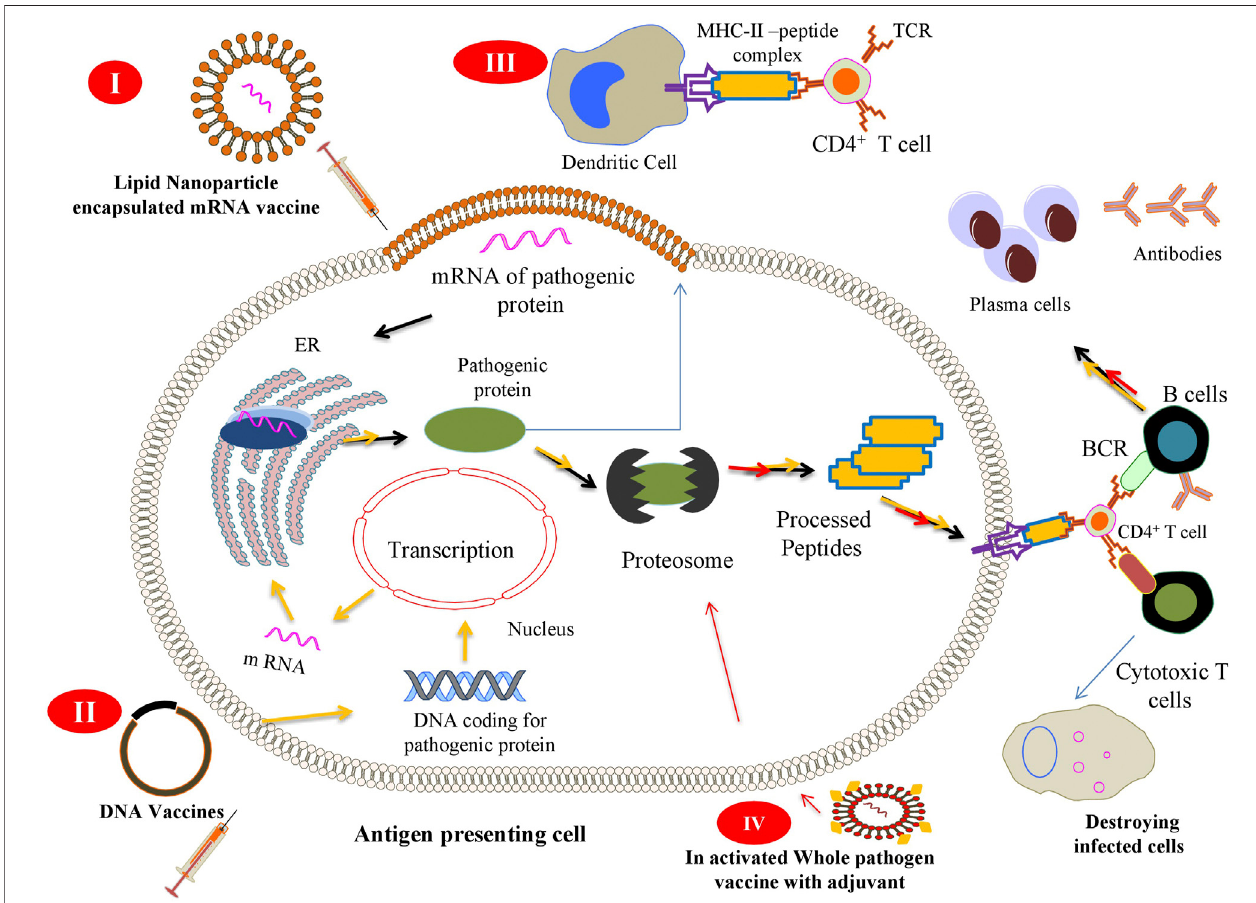
FIGURE 1 | Scheme of the different vaccine strategies: ( I ) Messenger RNA (mRNA) vaccines contain mRNA encoding a pathogenic protein that acts as an immunogen to elicit cellular and humoral immune responses. The vaccine is injected as a lipid nanoparticle encapsulation that, once released inside (depicted by black arrow ), the antigen-presenting cell (APC) is translated by cellular ribosomes and further presented on the surface of APCs. ( II ) DNA vaccines encoding a speci fi c sequence for a pathogenic gene are captured by APCs that express and present the antigen to immune cells to elicit immune response (process depicted by the yellowarrow ).( III )AfterexpressionofpathogenicproteinsinsideAPCs,itmaybesecretedinthesurroundingtissues(depictedby cyanarrow )wheredifferentotherAPCs can engulf, process, and present it to immune cells. ( IV ) Inactivated whole pathogen vaccines contain whole pathogens that have been subjected to heat or chemical inactivation when introduced into the body (depicted by red arrow ) and stay avirulent, but pathogenic. This strategy is not able to bring an effective cellular immune response because of the inactivation of immunogenic proteins, thus needing an adjuvant ( yellow dots ) to bring about such a response in the cells.